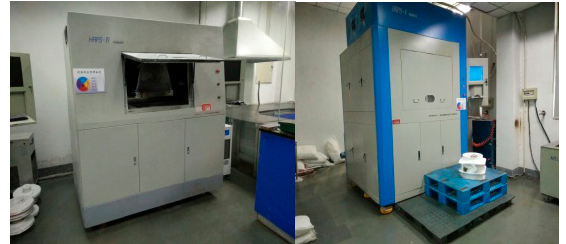
Figure 21. HRPS-V rapid prototyping machine.